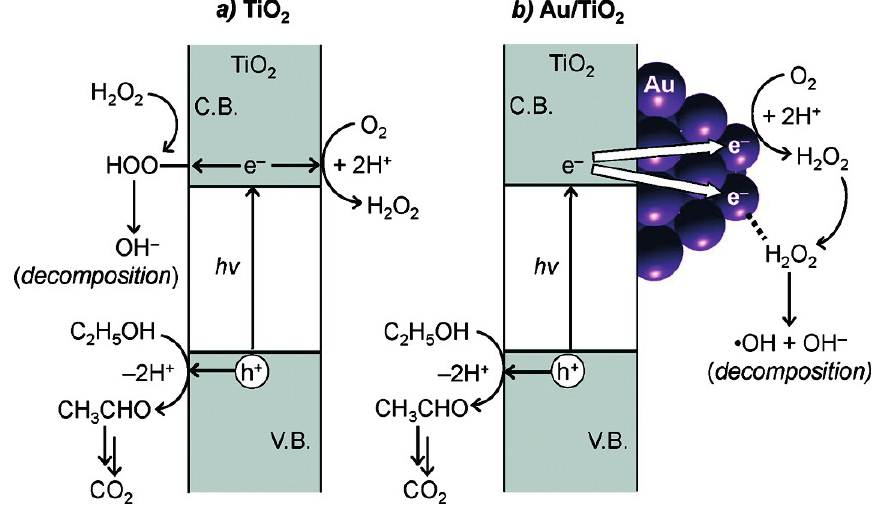
Figure 19. ( a ) Effect of pre-treating TiO 2 with phosphate on H 2 O 2 photosynthesis ( λ > 320 nm), and ( b ) 5 mM H 2 O 2 decomposition over 6 wt % rGO/TiO 2 (0.5 g/L) in O 2 -saturated aqueous buffer (pH 3) containing 5 vol % 2-propanol as hole scavenger; ( c ) Comparison of H 2 O 2 synthesis rates over rGO/TiO 2 (P) and 1 wt % metalized TiO 2 (P) samples; ( d ) Rate constants of H 2 O 2 synthesis (k f ) and decomposition (k d ) over TiO 2 (P)-supported composites (reproduced from [258] with permission of the Royal Society of Chemistry).